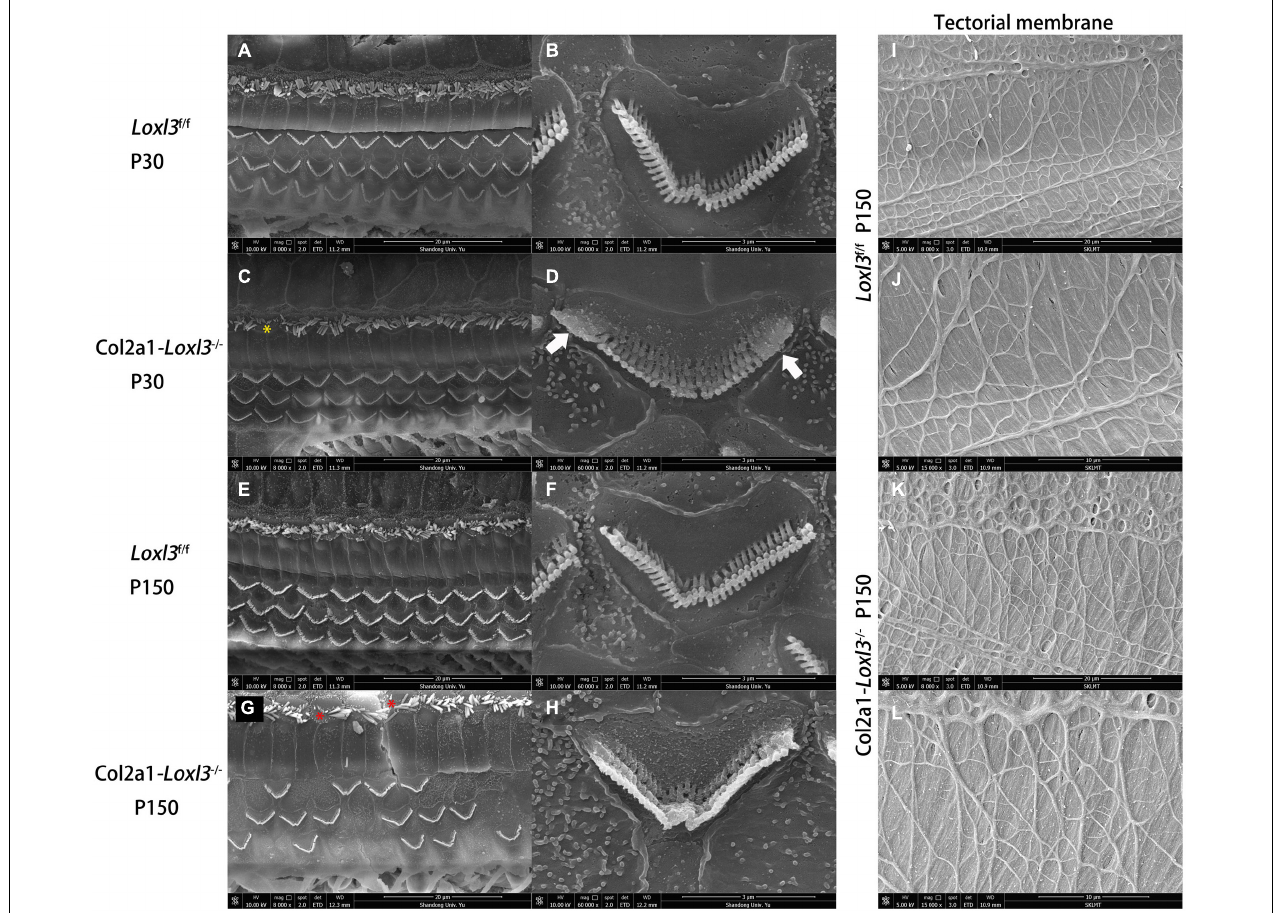
FIGURE 4 | The impaired stereocilia of the outer hair cells and inner hair cells and normal tectorial membrane in Col2a1–Loxl3 − / − mice. (A–D) Scanning electron micrograph of hair cell stereocilia in the basal turn of the Loxl3 f / f and Col2a1–Loxl3 − / − cochlea at P30. The magnification of the outer hair cells (OHC) in Col2a1–Loxl3 − / − mice showed partial stereocilia fusion (white arrow). And the stereocilia of inner hair cells in Col2a1–Loxl3 − / − mice showed spotty loss (yellow asterisk). (E–H) Scanning electron micrograph of hair cell stereocilia in the basal turn of the Loxl3 f / f and Col2a1–Loxl3 − / − cochlea at P150. The stereocilia of the outer hair cells (OHCs) in Col2a1–Loxl3 − / − mice showed serious impairment and complete stereocilia fusion, along with loss of OHCs. And the stereocilia of inner hair cells in Col2a1–Loxl3 − / − mice showed spotty loss (red asterisk). (I–L) Scanning electron micrograph of tectorial membrane in the basal turn of the Loxl3 f / f and Col2a1–Loxl3 − / − cochlea at P150. The magnification of the tectorial membrane TM in Col2a1–Loxl3 − / − mice showed